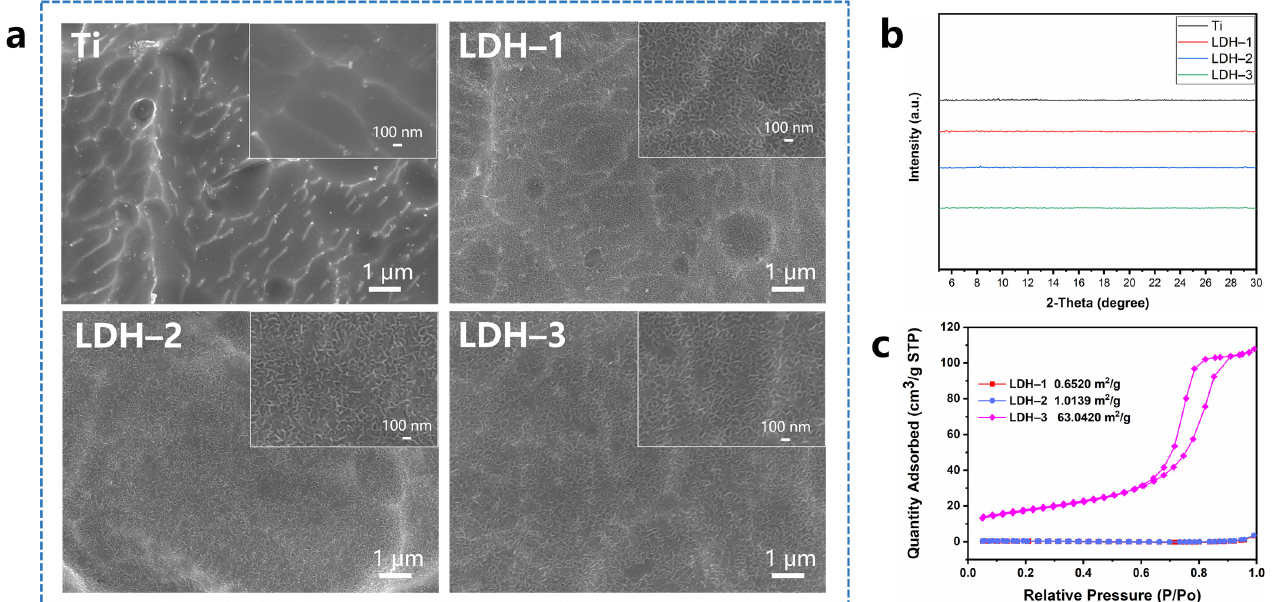
Figure 1. ( a ) SEM morphology of Ti, LDH − 1, LDH − 2, and LDH − 3 sample surfaces; ( b ) XRD diffraction pa tt erns of the Ti, LDH − 1, LDH − 2, and LDH − 3 samples; ( c ) N 2 absorption–desorption isotherms of LDH − 1, LDH − 2, and LDH − 3 samples.